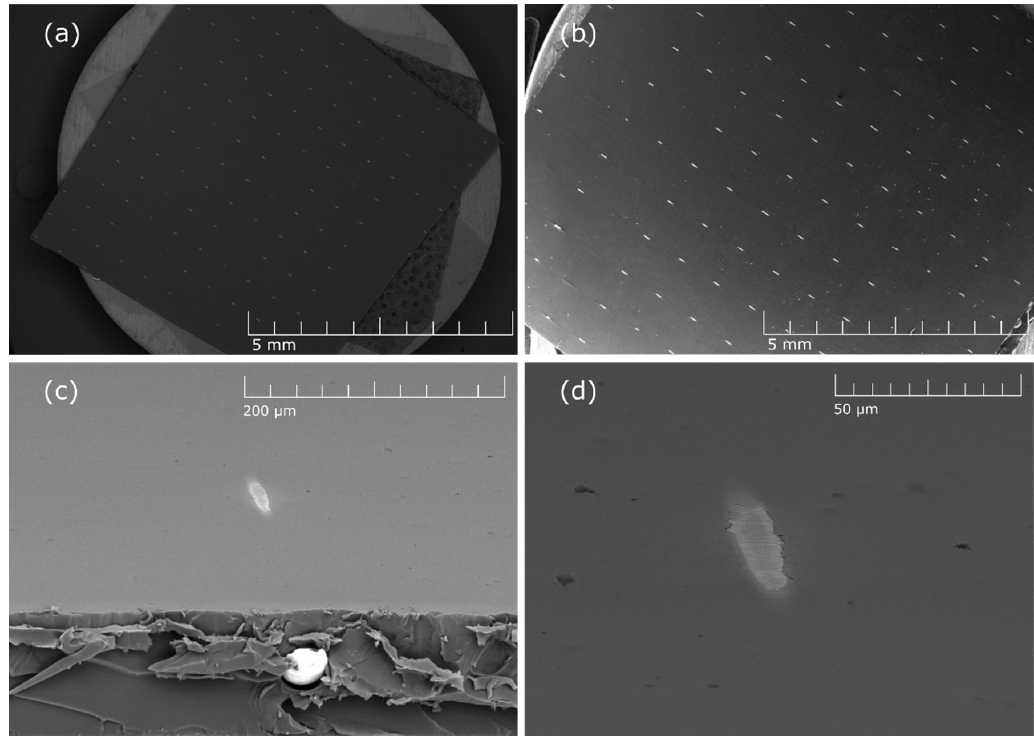
Figure 3. The surface of ( a ) untreated mesh foil and ( b ) the mesh foil after H 2 plasma etching (1 s) with details on cross-section and upper surface of exposed wires ( c ) and upper surface detail ( d ). The distance of the sample surface from the surface of concave DCSBD electrode system was H = 0.35 mm.